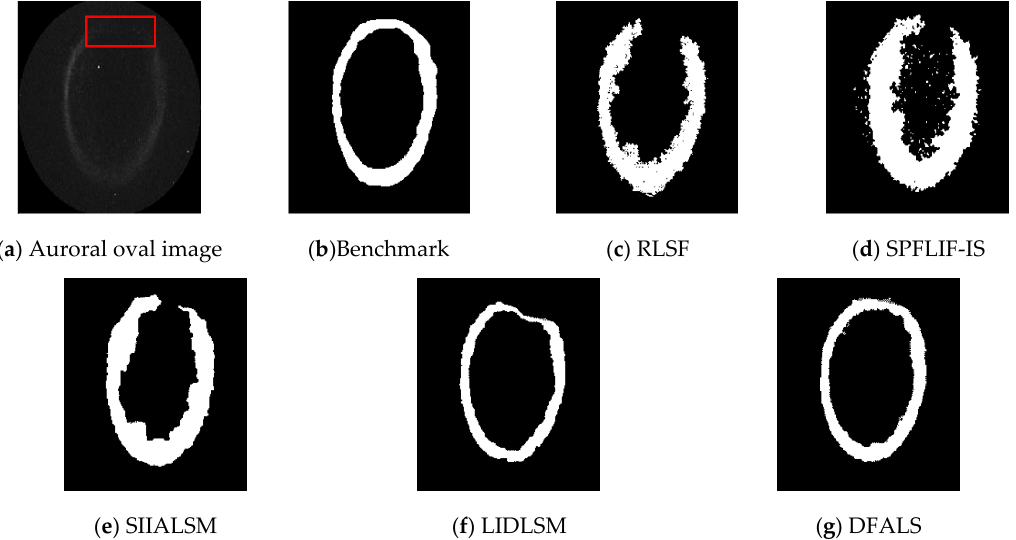
Figure 13. The segmentation results of different methods. ( a ) UVI image captured by polar satellite on